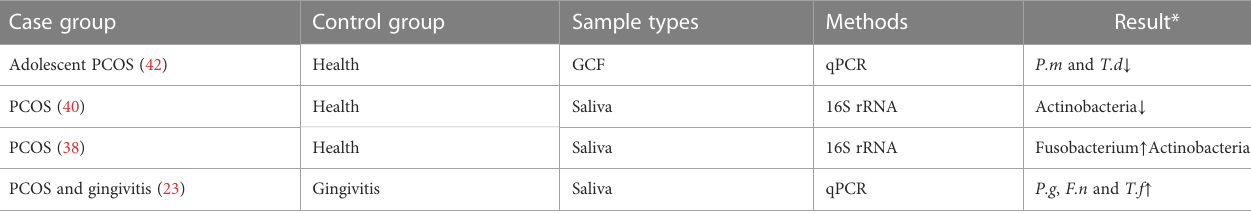
TABLE 2 Alteration of composition of oral microbial community in PCOS women. Case